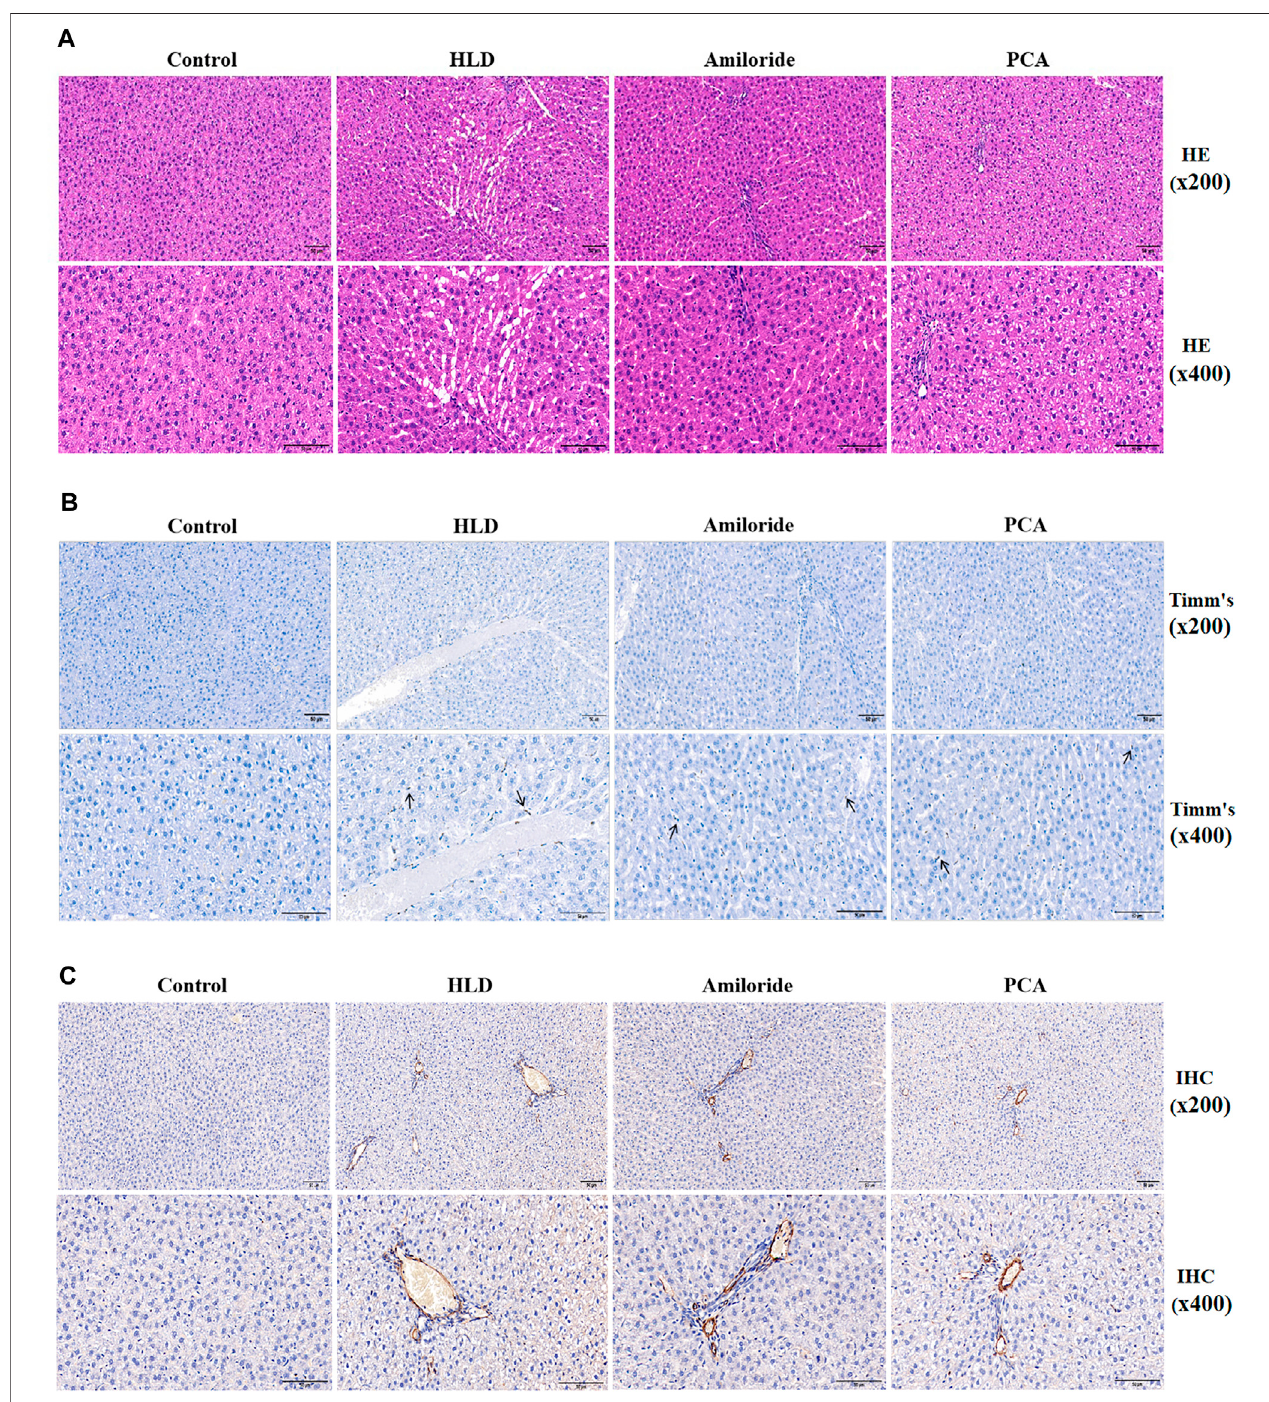
FIGURE 7 | Observation of pathological changes and α -SMA expression induced by Amiloride and D-penicillamine in the livers of copper-treated rats (A) Histopathologicalresultsoflivertissuesofratsineachgroup(scalebar,50 µM) (B) Timm ’ scopperstainingwasusedtoobservethedepositionofcopper particles inthe liver tissues of rats in each group (scale bar, 50 µM) (C) The immunohistochemical method was used to detect α -SMA protein expression in liver tissues of rats in each group (scale bar, 50 µM).